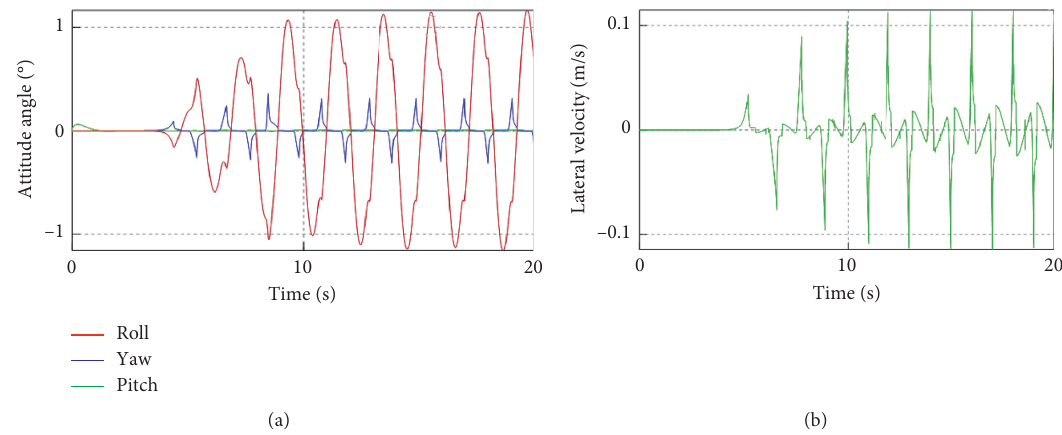
Figure 7: Changes of the single-bogie vehicle after the introduction of supporting wheels. (a) Attitude angle. (b) Lateral velocity.